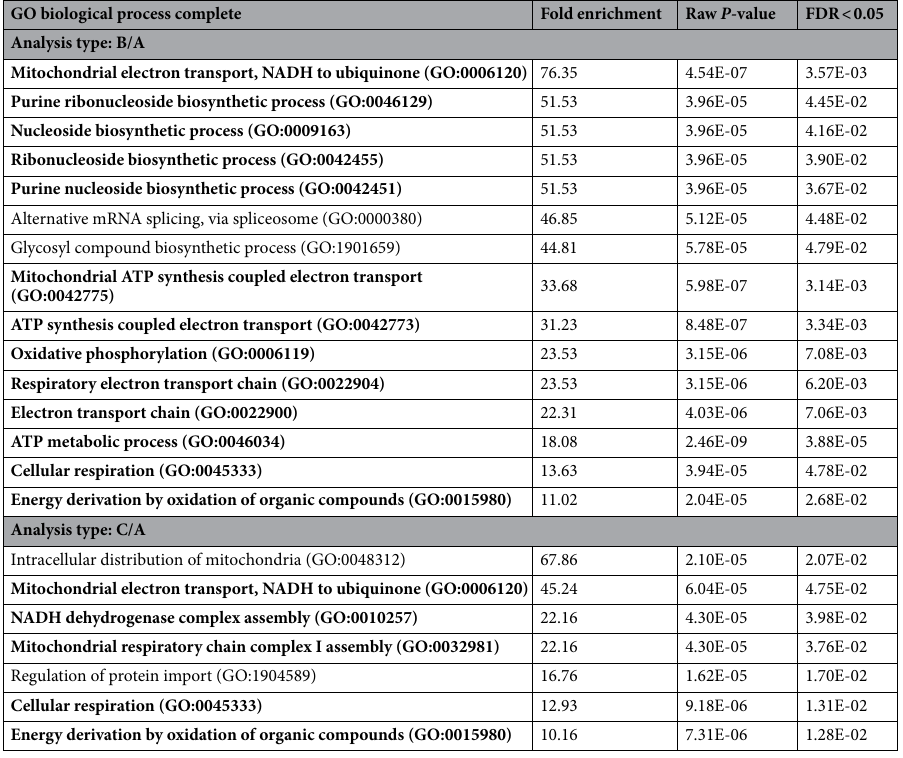
Table 1. Gene Ontology analysis of significantly altered biological processes in 2DG treated murine heart indicates that the principal effects of the compound are to augment the expression of proteins related to the respiratory chain and ATP synthesis. Upper section 2DG treated group B vs. controls (A), based on 64 significantly altered proteins. Lower section, 2DG treated group C vs. A (81 proteins). The peptide abundances were converted to log2 and a t-test applied and filtered, criteria for inclusion: FDR < 0.05; > tenfold enrichment. GO processes in bold relate to mitochondrial energy production and ATP